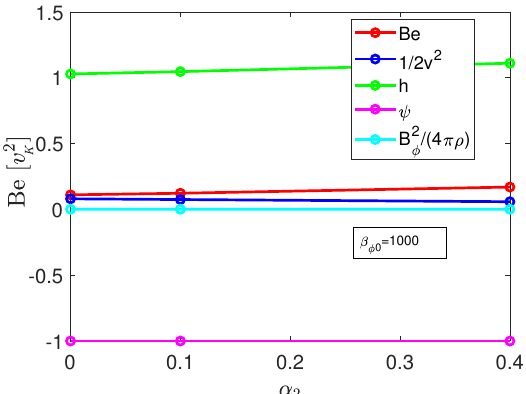
. Here, the gas pressure is 1000 times larger than the magnetic k